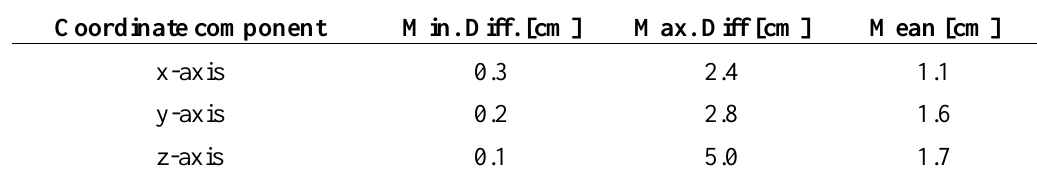
Table 1 . Differences in coordinate components in Case 1